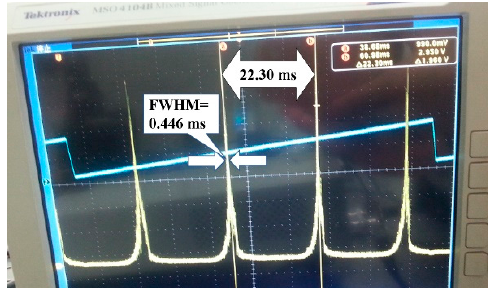
Figure 8. Spectral linewidth measured by a scanning Fabry-Perot interferometer with 10 GHz FSR.